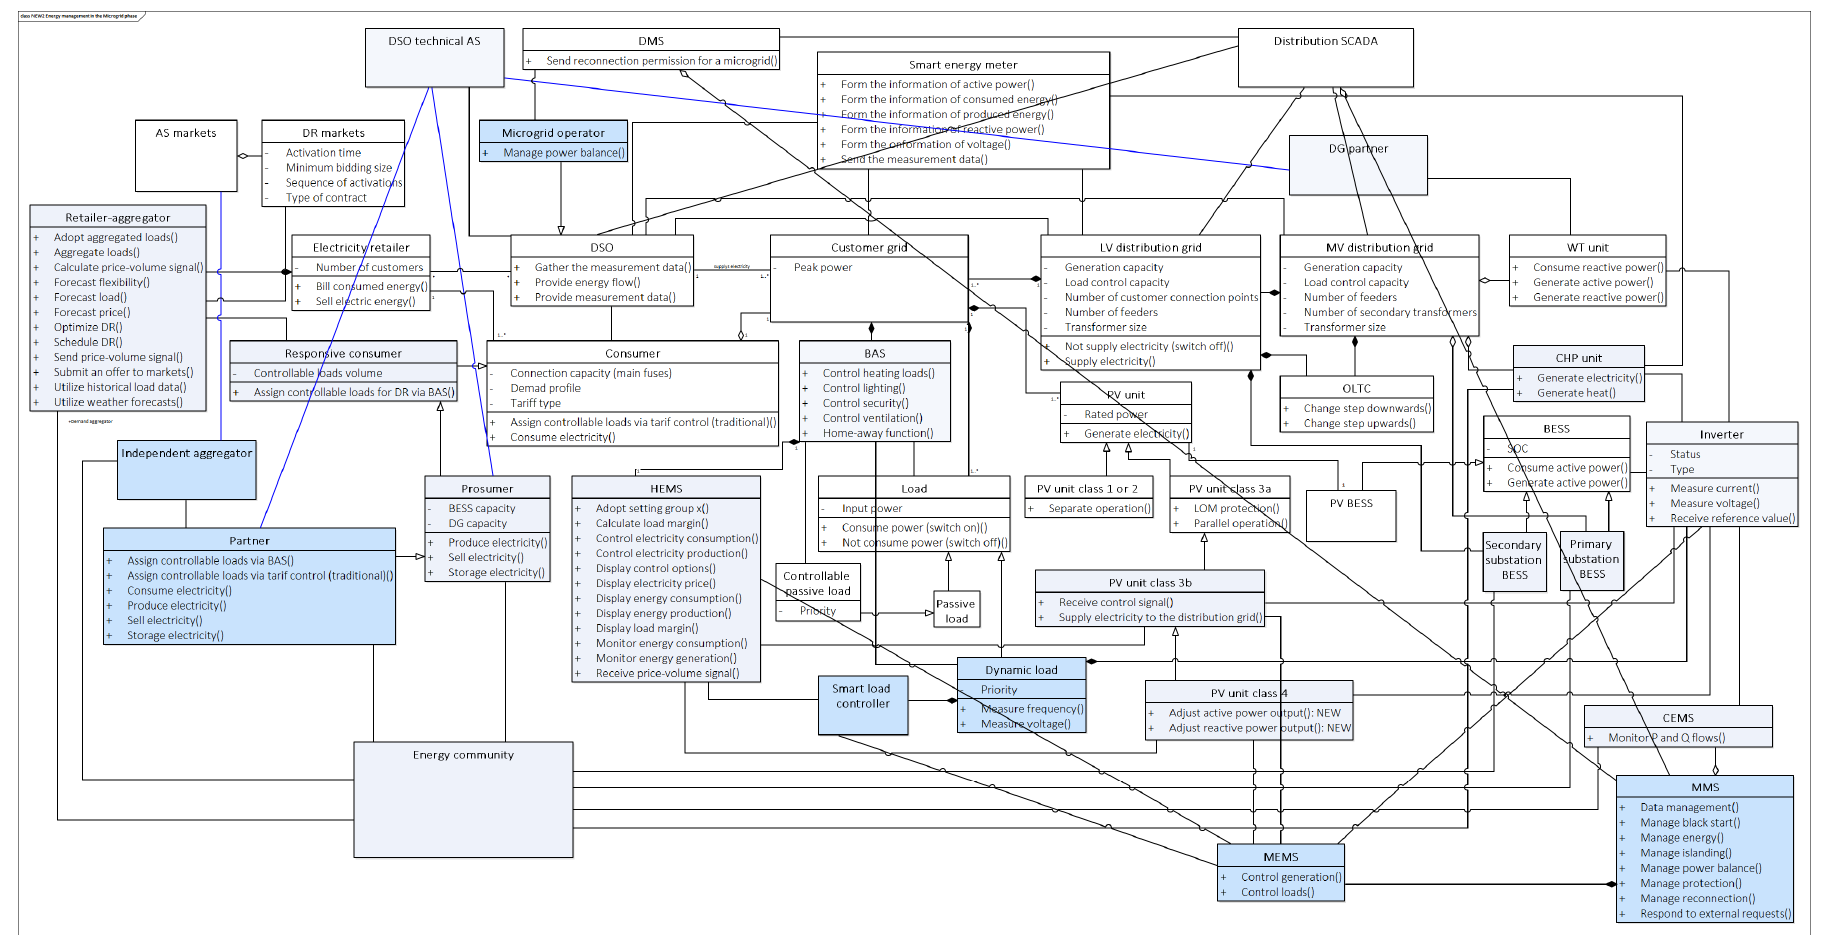
Figure A1. Class diagram of the energy management of the microgrid phase.